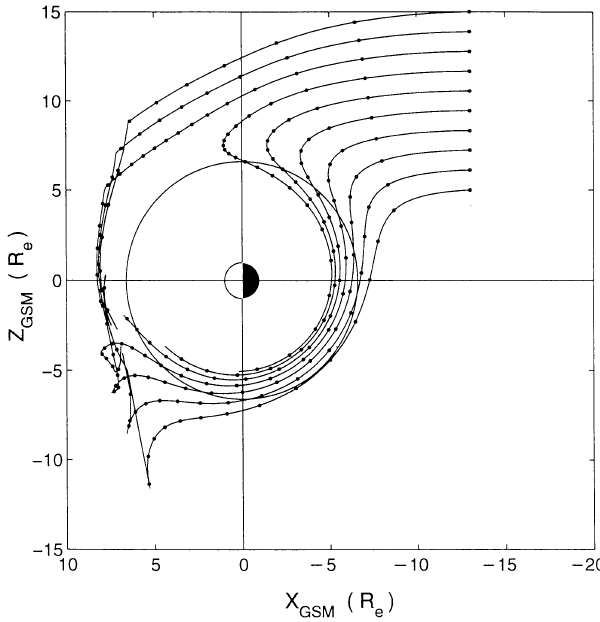
Fig. 12. Drift trajectories of protons with an initial energy of 0.5 keV and pitch angle 45 ° in a dawn-dusk electric field of 0.1 mV per meter. Such particles may be the source of the 3 keV population occurring simultaneously with the ring current in Fig. 10